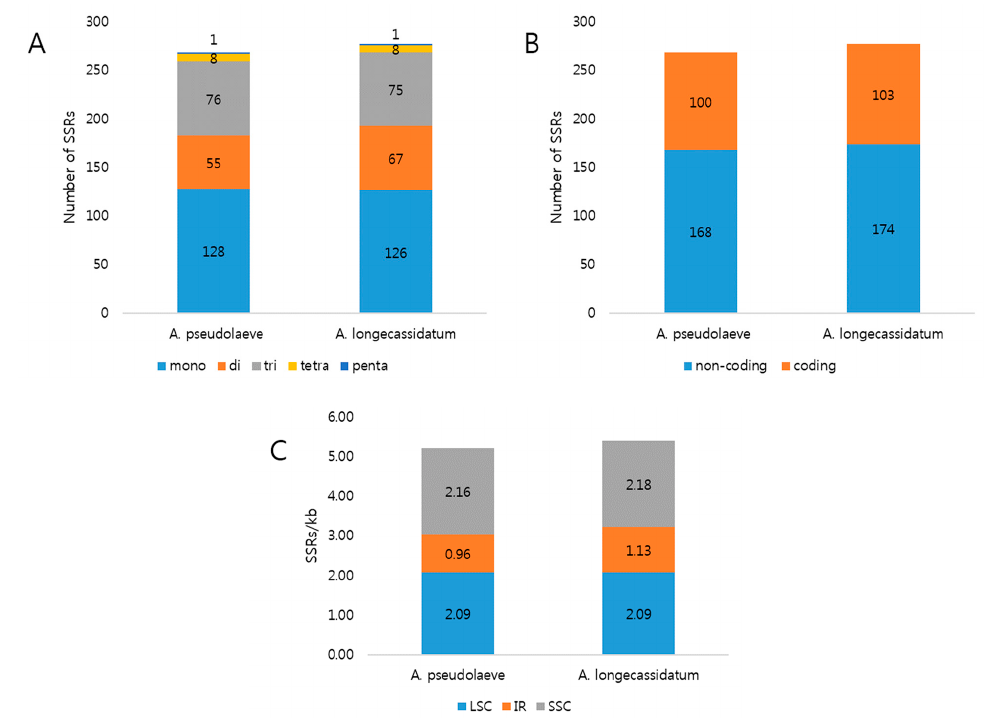
Figure 3. Distribution of simple sequence repeats (SSRs) in A. pseudolaeve Nakai and A. longecassidatum Nakai CP genomes. ( A ) Distribution of SSR types in the two Aconitum CP genomes. ( B ) Distribution of SSRs between coding and non-coding regions. ( C ) Number of SSRs per unit length in the indicated genomic regions of Aconitum CP genomes. CP: chloroplast; LSC: large single copy; IR: inverted repeat; SSC: small single copy.